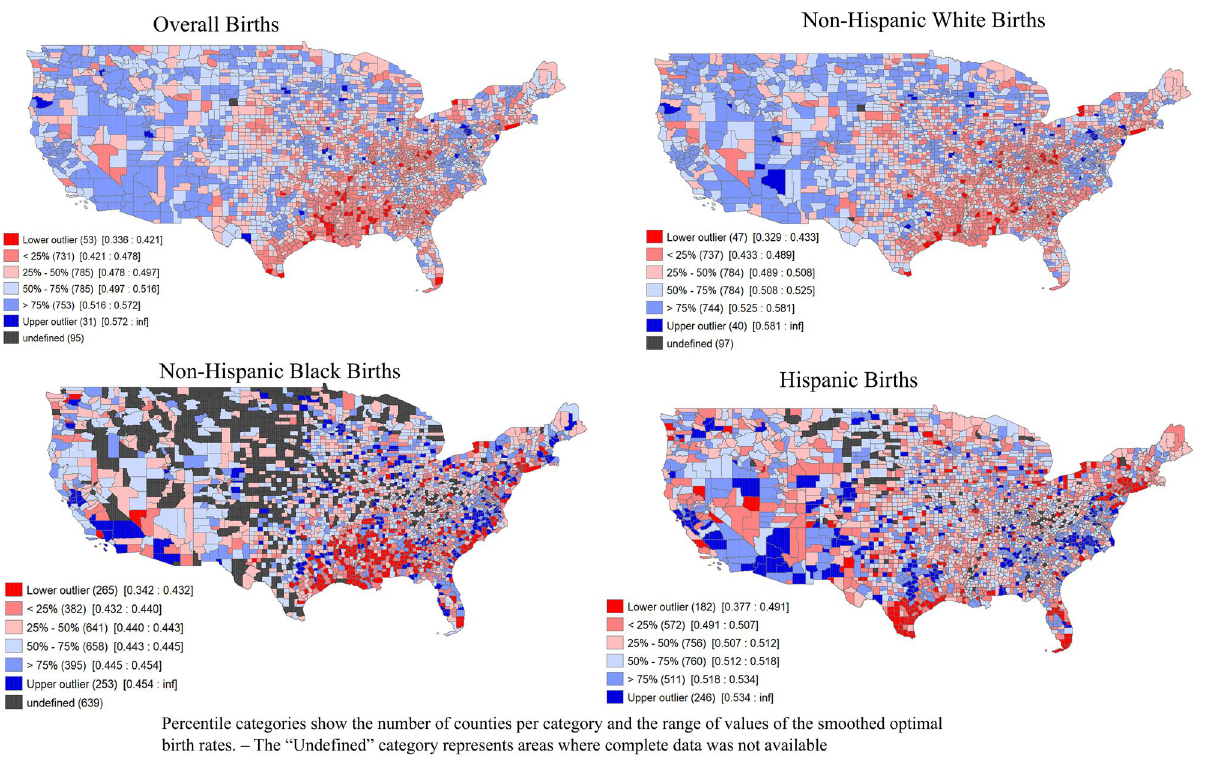
Figure 1. Overall and race-specific county-level empirical bayes smoothed rates of optimal births, 2018–2019. Map generated in Geoda version 1.18.0.10 (https:// spati al. uchic ago. edu/ geoda).